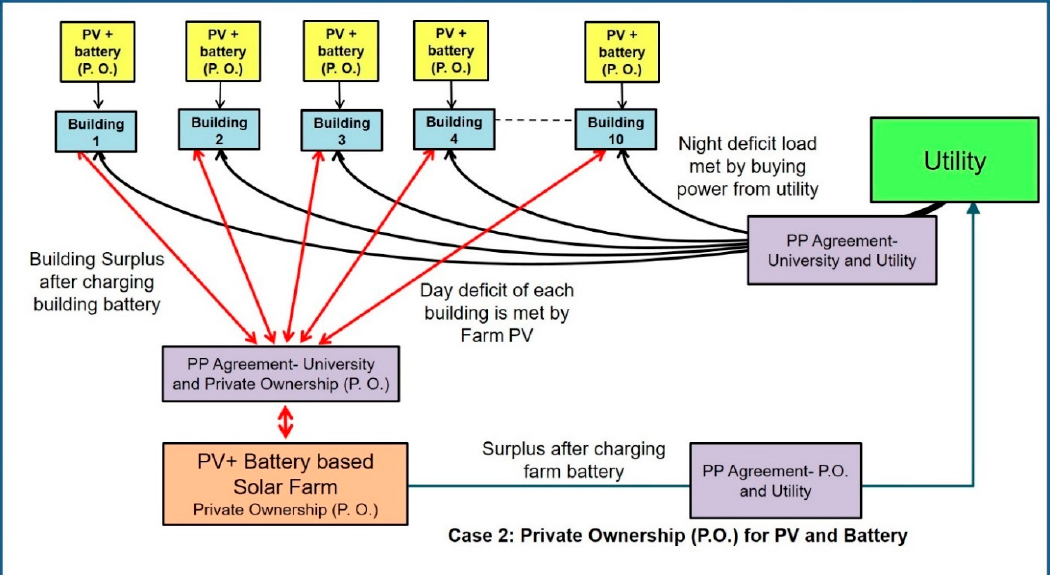
Figure 13. Financial analysis is based on the fact that the owner of the entire power network is either the utility or some other investor. It is assumed that between the university, utility and investor, a PPA has been signed. The utility will supply the deficiency of power generated by the PV system.